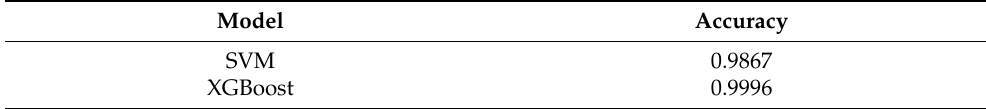
Figure 19. Feature Correlation. Table 2. The accuracy of XGBoost and SVM